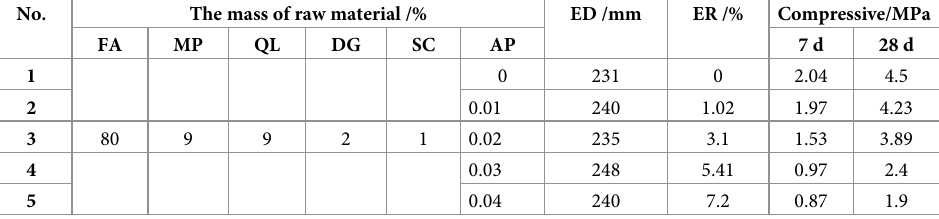
Aluminum powder was added at the mass percentage of total material amount and added as via the described method.